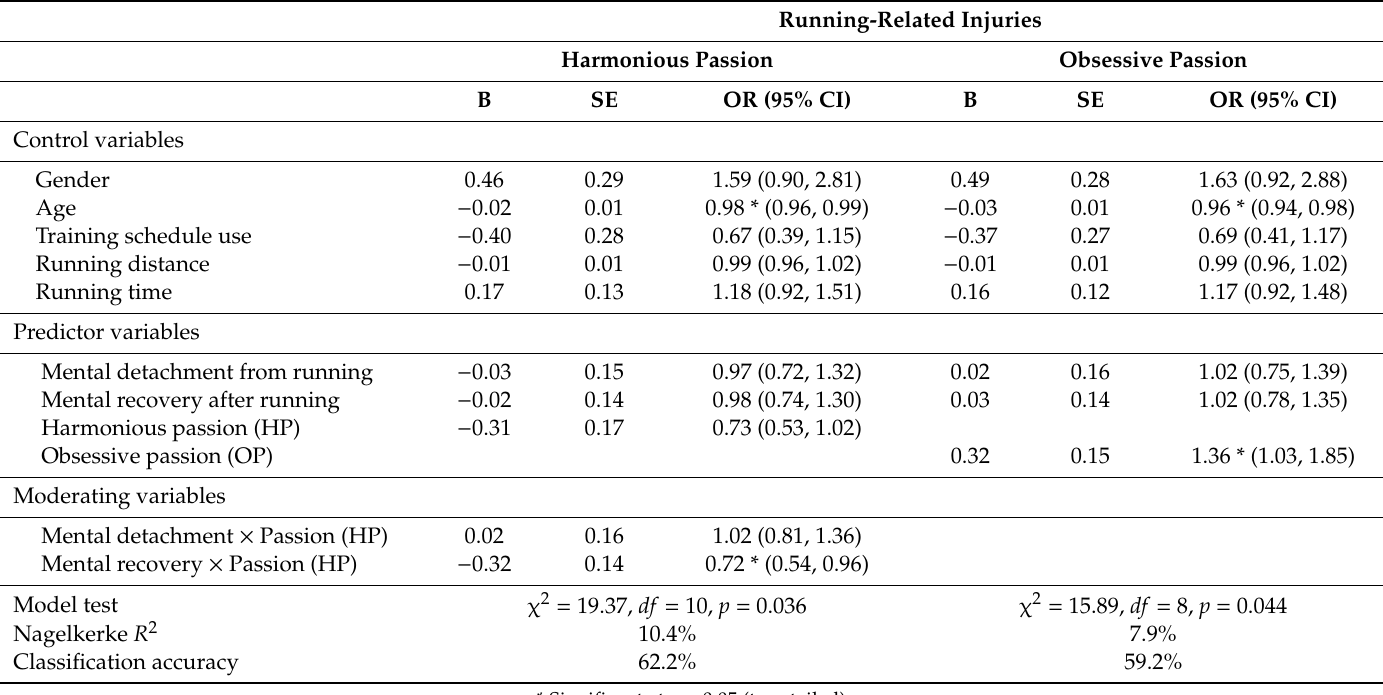
Table 2. Logistic regression models of running-related injuries with detachment, recovery and passion as predictor variables ( n =